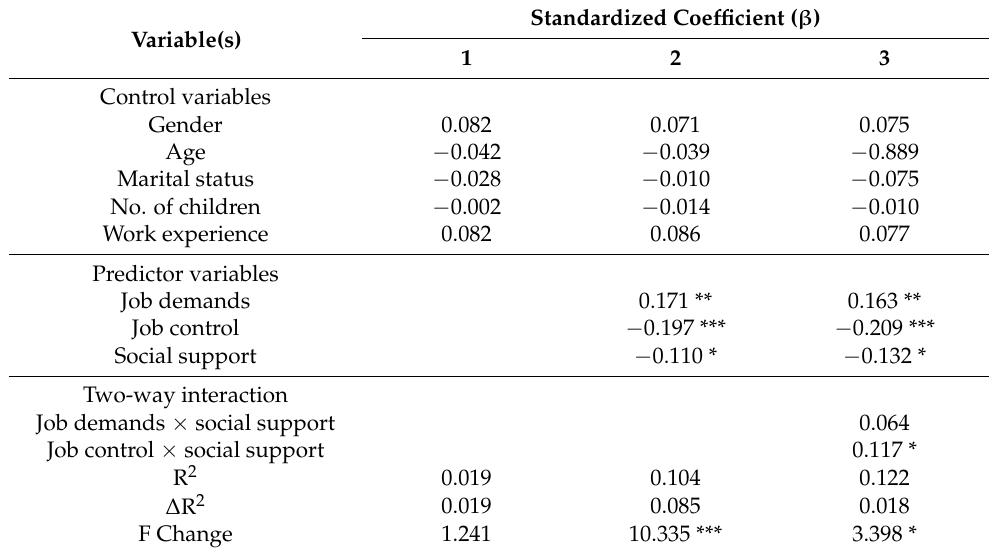
Table 7. The results of hierarchical linear regression model in predicting